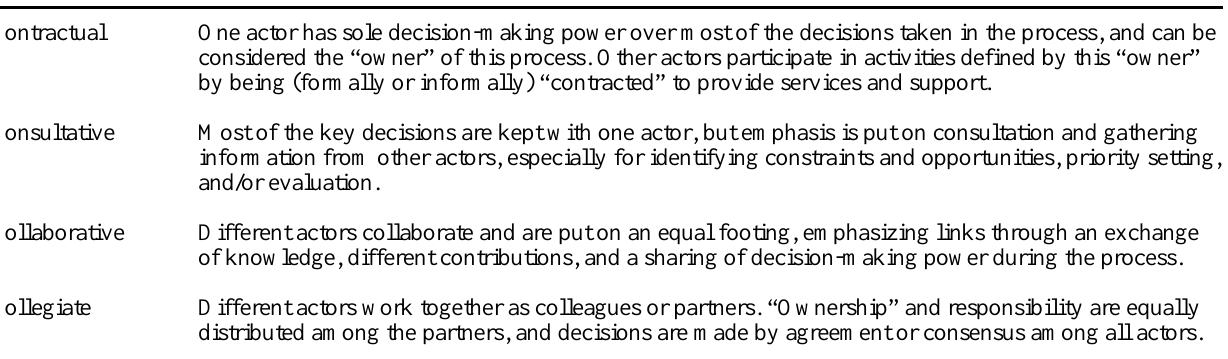
Table 1. Different participation modes in research and innovation processes (adapted from Probst and Hagmann